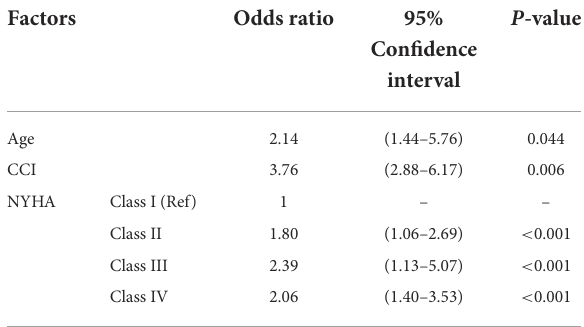
TABLE 6 Logistic regression analysis for predicting risk factors associated with readmission of patients at 30